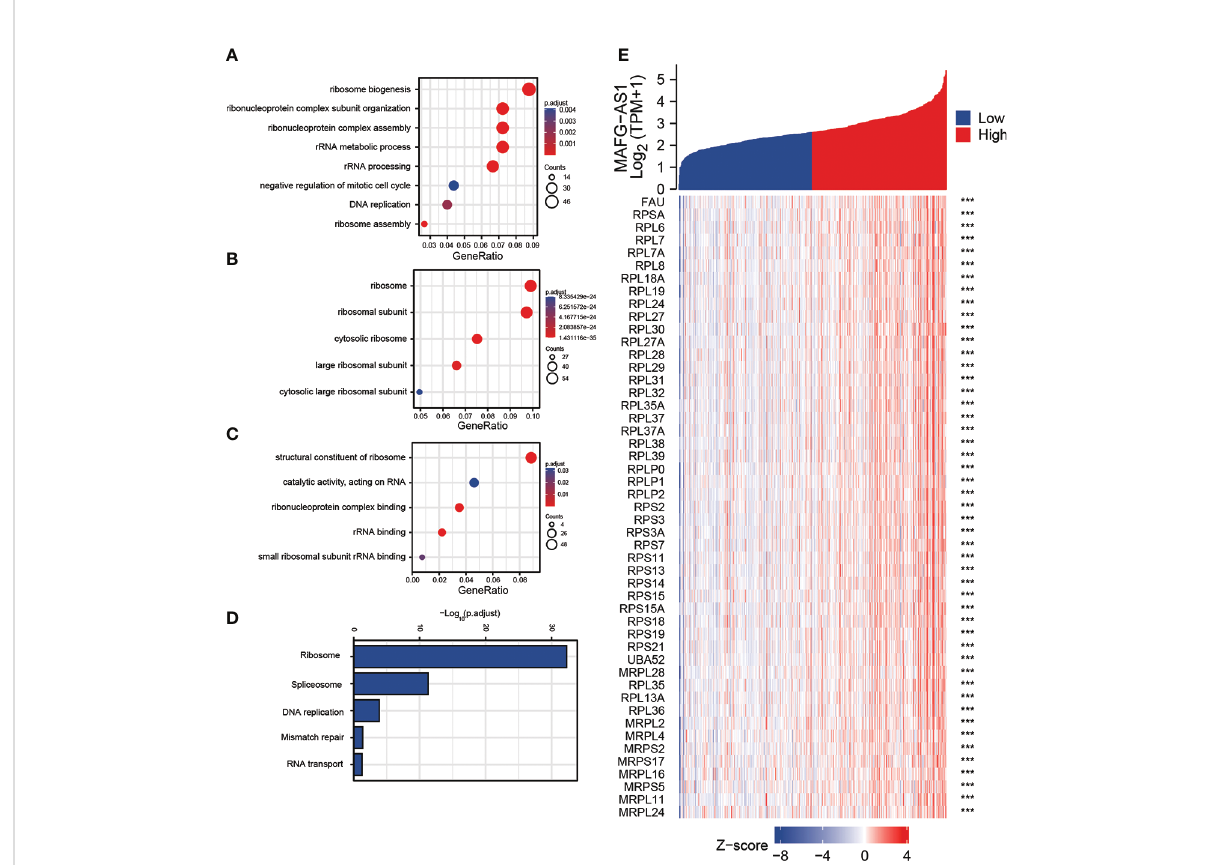
FIGURE 4 Gene functional enrichment analysis of the most relative genes with MAFG-AS1 expression. (A) Gene Ontology analysis of MAFG-AS1 related genes in biological process (BP). (B) Gene Ontology analysis of MAFG-AS1 related genes in cellular component (CC). (C) Gene Ontology analysis of MAFG-AS1 related genes in molecular function (MF). (D) Kyoto Encyclopedia of Genes and Genomes (KEGG) pathway analysis of MAFG-AS1 related genes. (E) The correlation analysis between MAFG-AS1 and ribosome related genes. ns P ≥ 0.05, * P < 0.05, ** P < 0.01, *** P <